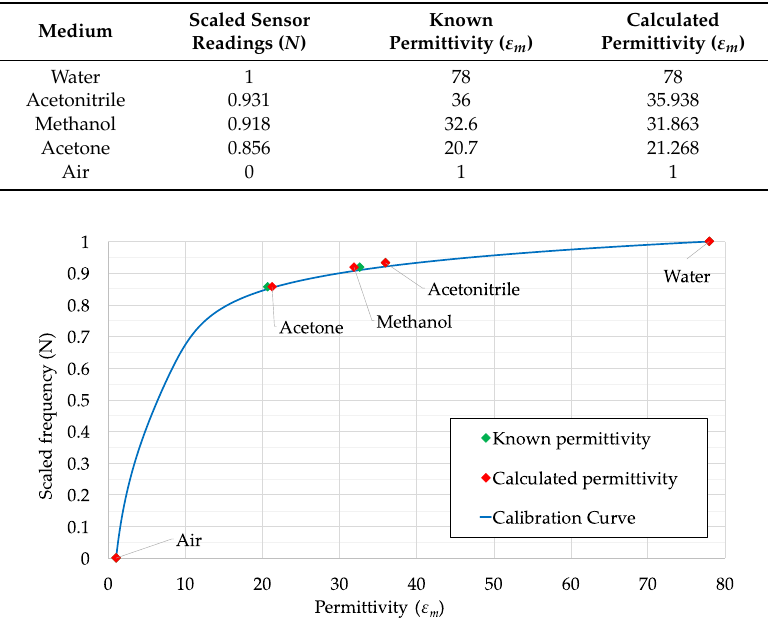
Figure 8. Calibration curve from calibrations tests.